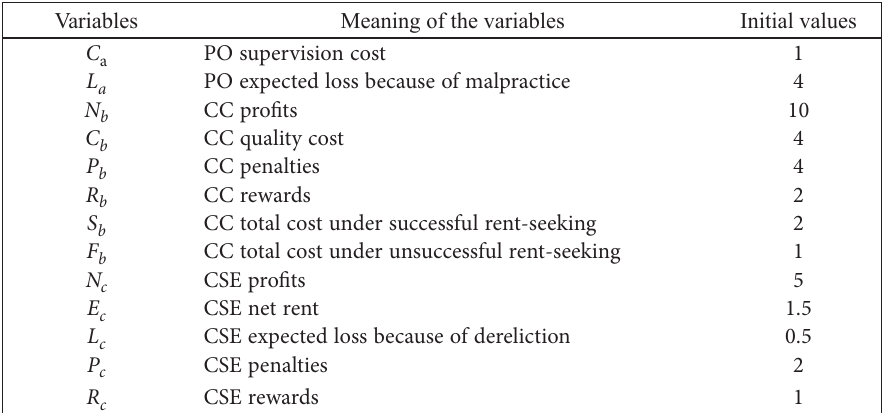
Table 2. Initial values of external variables in the SD